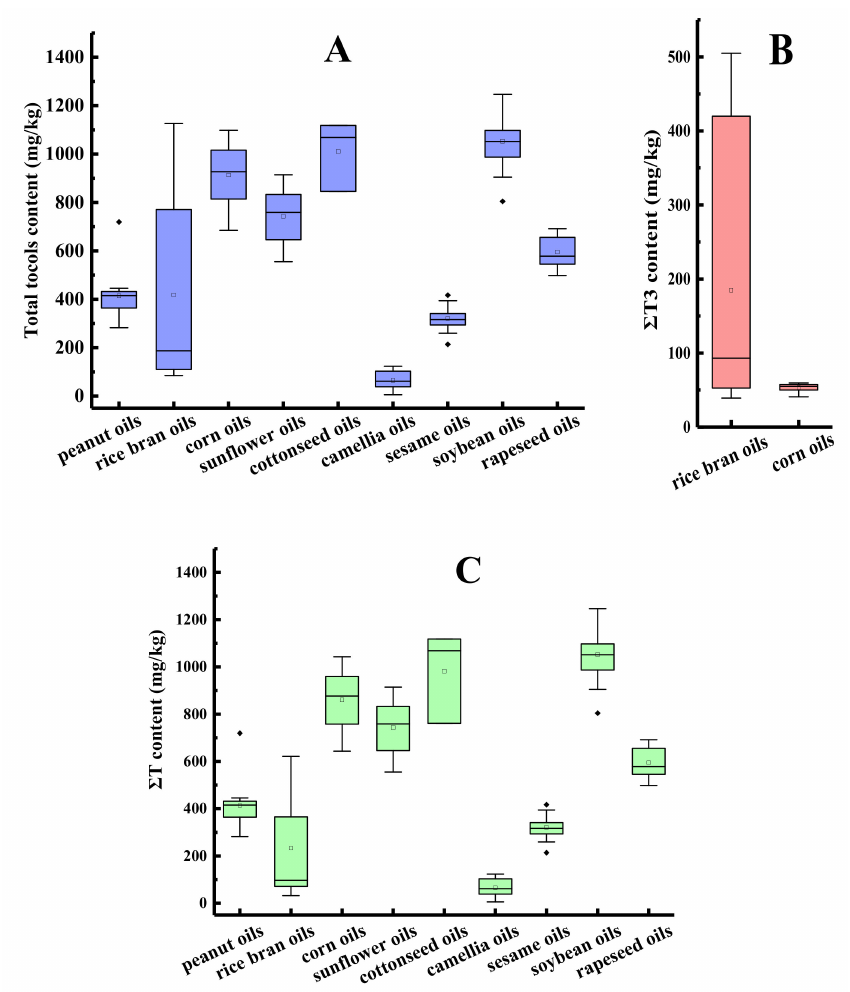
Figure 2. The tocol contents in di ff erent species of first-grade traditional edible oils (mg / kg). ( A ) Total tocol content; ( B ) Σ T3 content; ( C ) Σ T